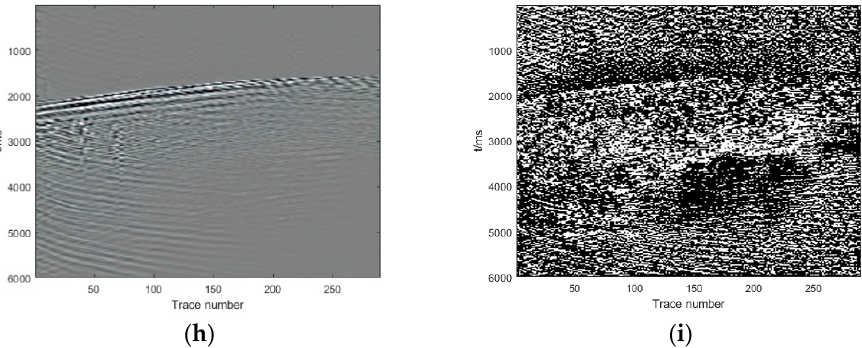
Figure 11. Denoising results of the second field example. ( a ) Noisy data; ( b ) Denoised image through the pre-trained model; ( c ) The difference profiles between noisy data ( a ) and pre-denoised data ( b ); ( d ) Denoised data through the proposed method; ( e ) The difference profiles between noisy data ( a ) and denoised data ( d ); ( f ) Denoised data through the DnCNN; ( g ) The difference profiles between noisy data ( a ) and denoised data ( f ); ( h ) Denoised data through the U-net; ( i ) The difference profiles between noisy data ( a ) and denoised data ( h ).